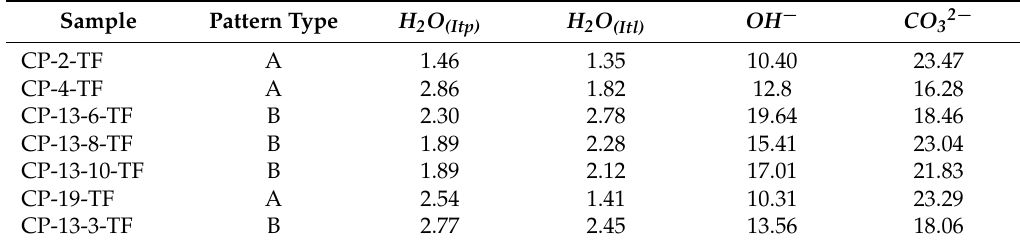
Table 3. Thermo-gravimetric analysis results (wt %) of target fractions of mortar binders.